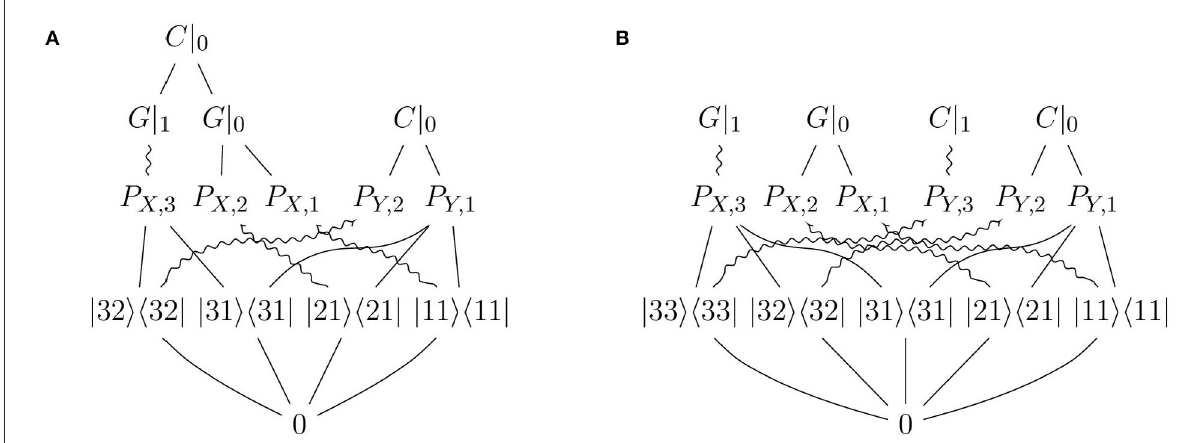
FIGURE10 The semantic structures for H X and H Y combined after m 4 (A) and after m 5 (B) .